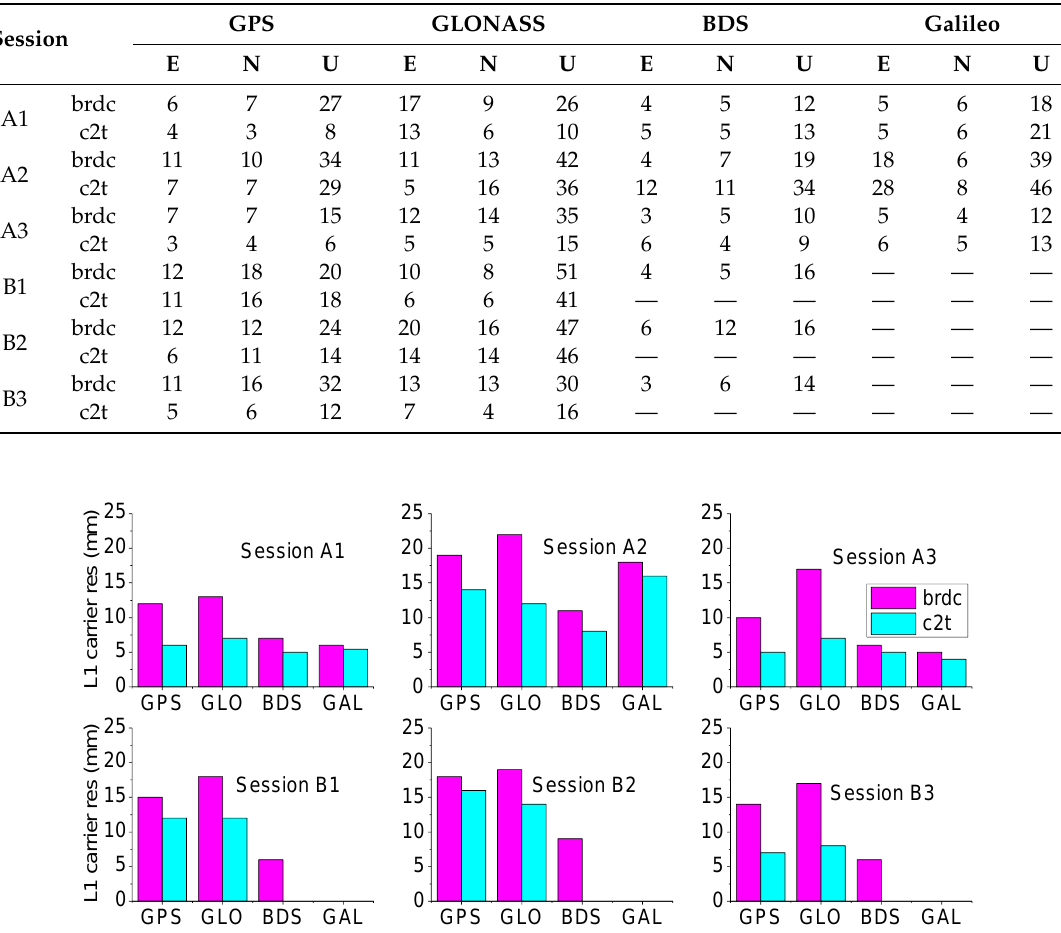
Figure 11. L1 carrier residuals for GPS, GLONASS, BDS, and Galileo ARTK using broadcast, c2t ephemeris.